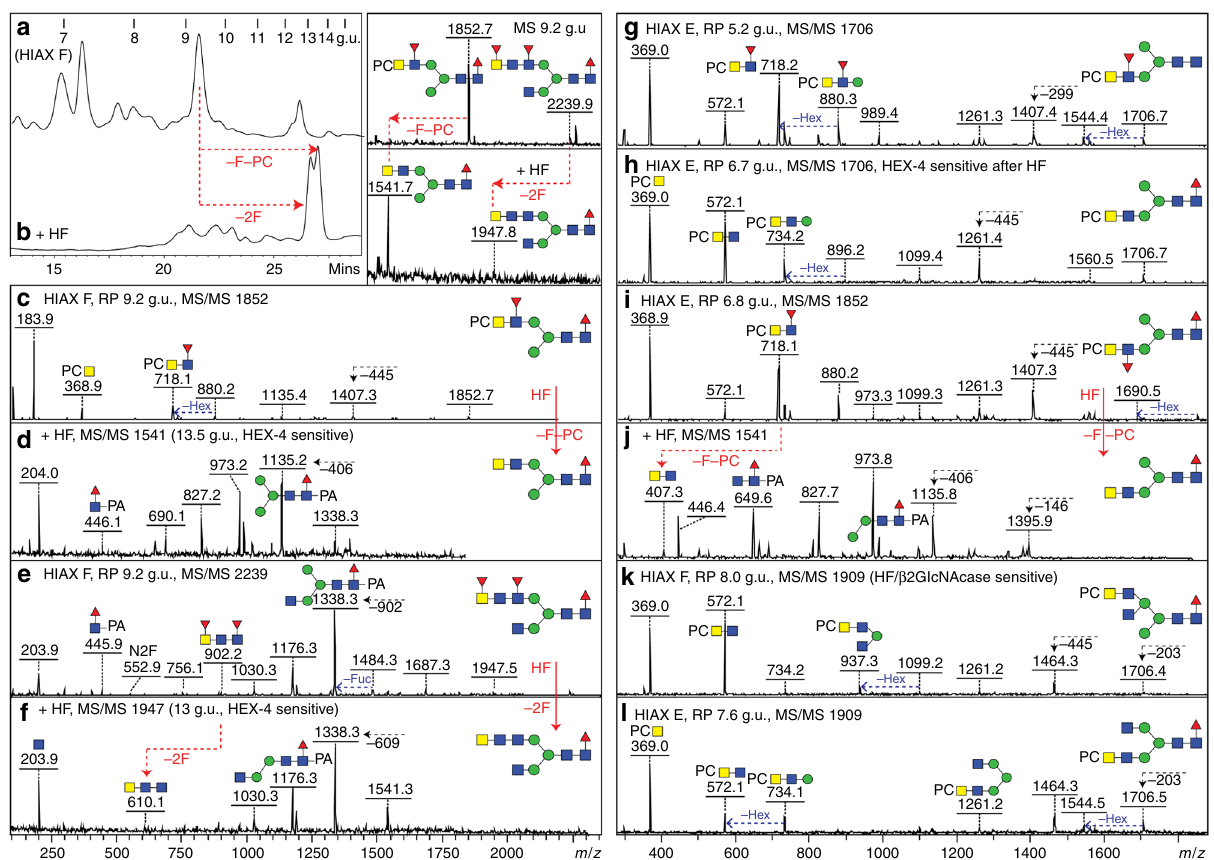
Fig. 3 Analysis of example phosphorylcholine and fucose-modi fi ed N-glycans. a – f RP-amide HPLC, MALDI-TOF – MS and MS/MS analysis of an example 2D-isolated fraction before ( a , c , e ) and after ( b , d , f ) hydro fl uoric acid treatment. A shift to higher elution due to altered hydrophobicity of the glycans ( b ) and alterations in the MS/MS spectra (removal of one fucose and one phosphorylcholine from m / z 1852 or of two fucoses from m/z 2239 correlating with losses of the m / z 184 (PC + H 2 O), 369 (GlcNAc 1 PC), 718 (HexNAc 2 Fuc 1 PC) and 902 (HexNAc 3 Fuc 2 ) B-fragment ions) verify the proposed compositions, whereas the ability to remove one GalNAc from both with HEX-4 (data not shown) enabled the proposition of the isomeric structure. g – l MS/MS of other phosphorylcholine-containing glycans as well as one example ( j ) after hydro fl uoric acid treatment; other sensitivities to this reagent or to hexosaminidases are noted. The contrast in the spectra of the two isomers of Hex 3 HexNAc 4 Fuc 1 PC 1 ( m / z 1706; g , h ) is due to the position of the fucose residue. Selected B- and Y-fragments are annotated as well as certain losses of fucose or hexose; due to the excellent ionisation of PC-containing fragments (e.g. at m / z 718 and 572), the presence of core fucose is shown by the loss of 445 Da from the parent and by the presence of an m / z 446 Y-fragment observable after hydro fl uoric acid treatment. The terminal position of phosphorylcholine is inferred by the minimal fragment containing both the PC and